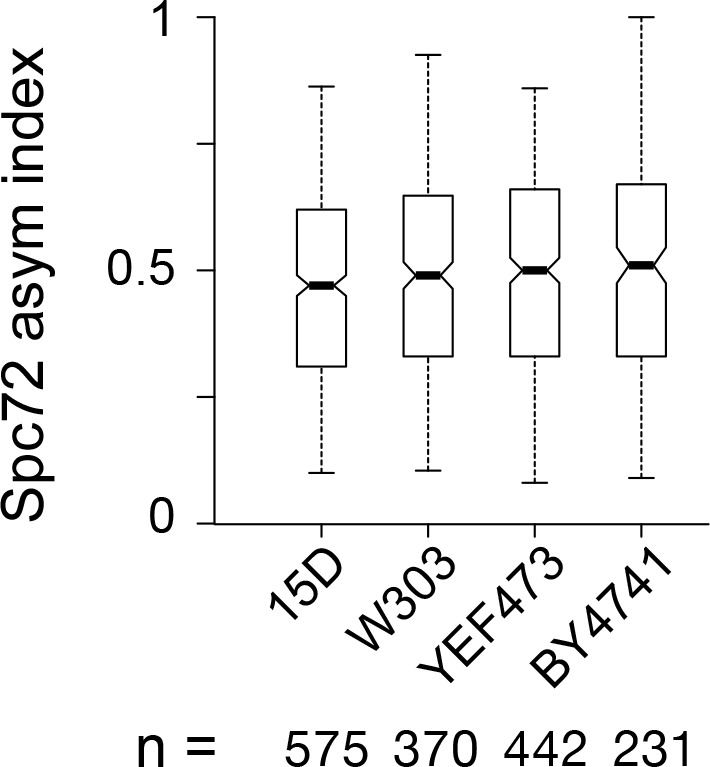
Spc72 asymmetry in multiple yeast genetic backgrounds.Boxplot for the distribution of Spc72 asymmetry index in short spindles (<2.5 µm-long) for asynchronous cultures in the indicated wild type yeast backgrounds from wide-field images. Boxplots depict the 5th, 25th, 50th, 75th and 95th centiles. Notches represent 95% CI of the median.